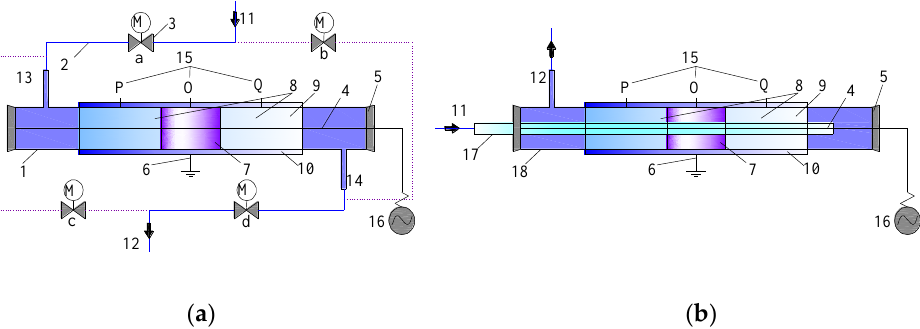
Figure 12. ( a ) DBD reactor and ( b ) DDBD reactor. Schematic diagram of reaction device: 1. quartz tube; 2. gas pipeline; 3. solenoid valve; 4. high voltage; 5. insulating plug; 6. grounding pole; 7. discharge area (catalyst section); 8. heat storage section; 9. regenerator; 10. insulating cotton; 11. main